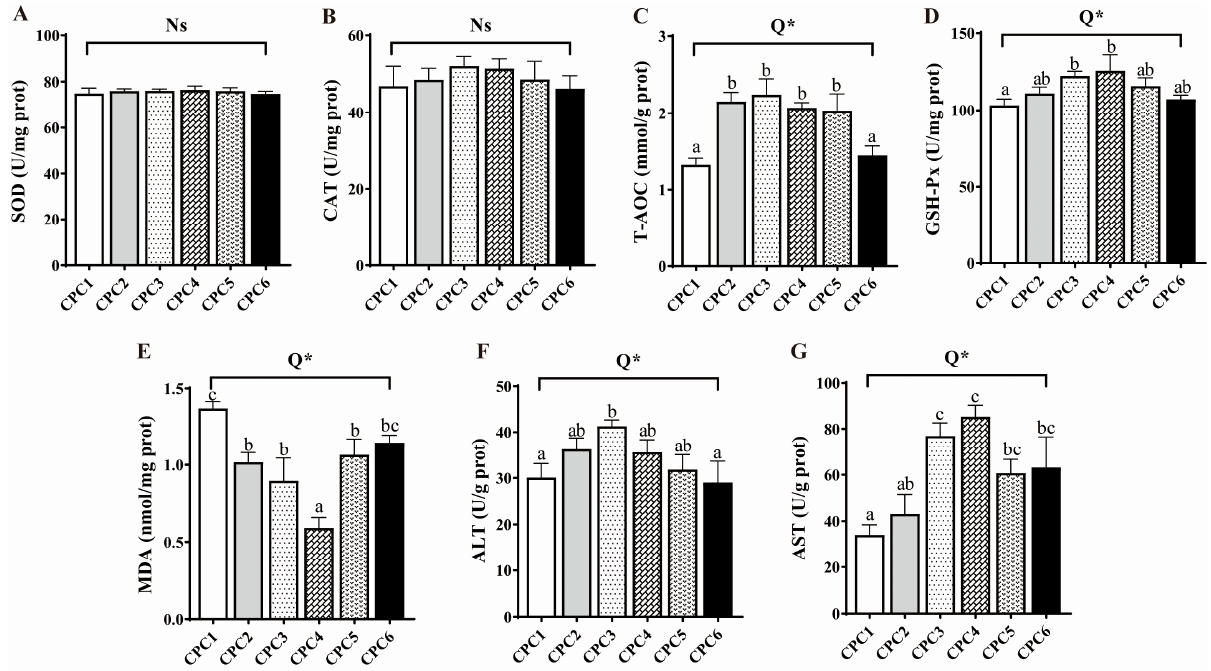
Figure 2. Effects of the dietary protein levels on antioxidative capacity and transaminase activities of grass carp hepatopancreas. ( A – G ) SOD: superoxide dismutase; CAT: catalase; T-AOC: total antioxidant capacity; GSH-Px: glutathione peroxidase; MDA: malondialdehyde; ALT: alanine